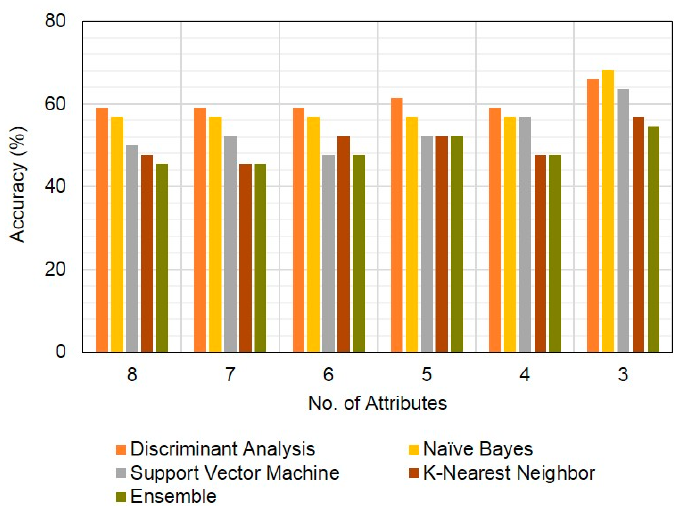
Figure 20. Accuracy for the new wells by machine learning methods and number of attributes.